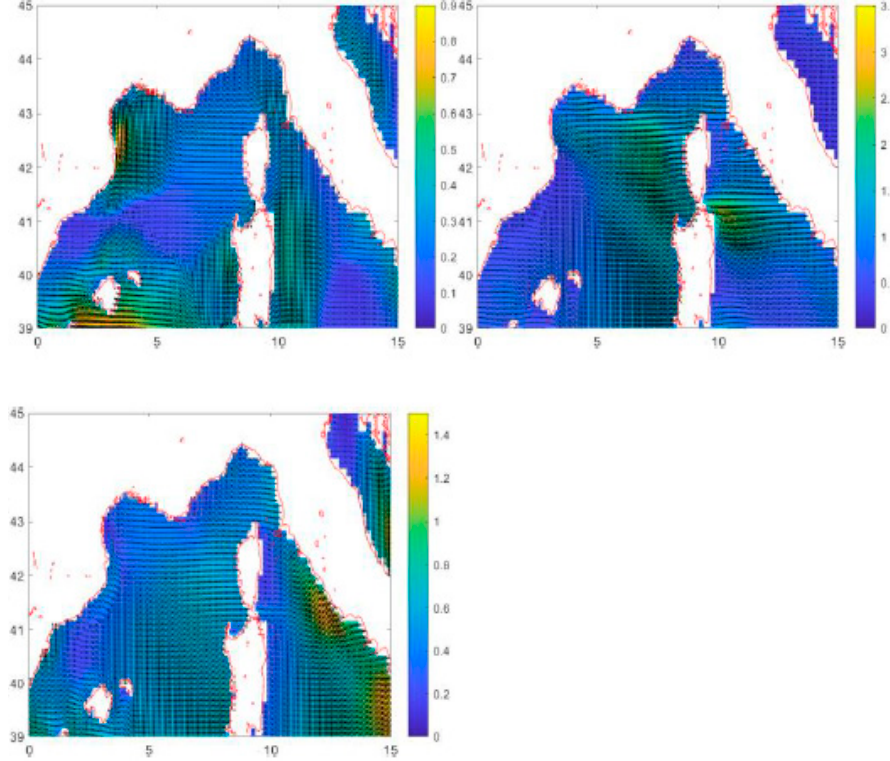
Figure 4 . June–July–August. Source: Ship weather routing software output, Authors Figure 4. June–July–August. Source: Ship weather routing software output, Authors (2020).